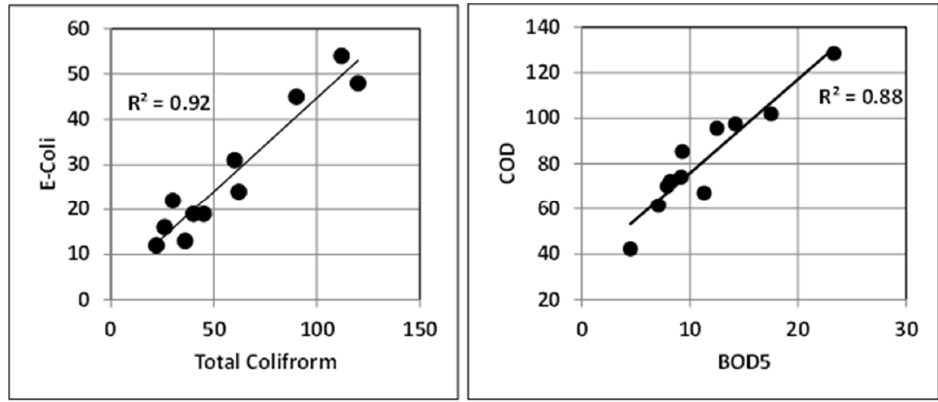
Figure 6. Correlation between total coliform with E-Coli (left) and BOD5 with COD (right).